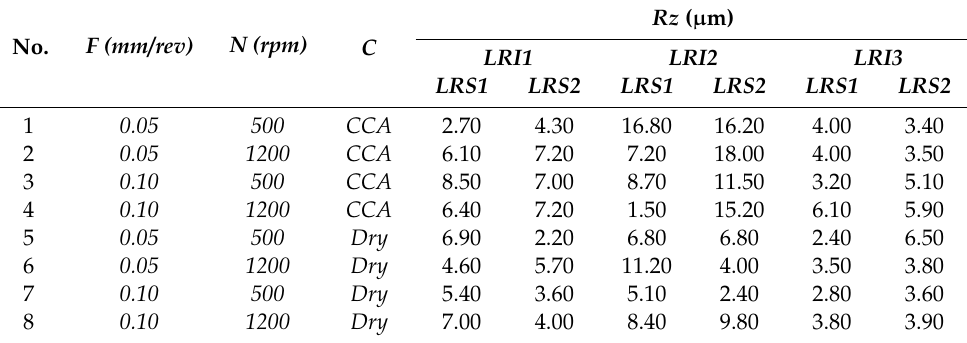
Table 7. Values of Rz in each plate at the entry and exit zones of the